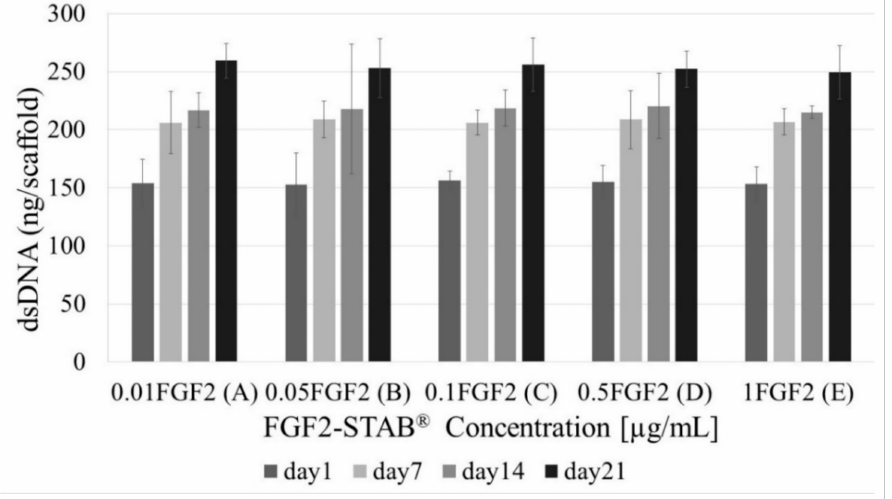
Figure 9. dsDNA assay with increasing FGF2-STAB ® concentration (0.01, 0.05, 0.1, 0.5 and 1 µ g/mL, for A – E , respectively) after 1, 7, 14 and 21 days of incubation. No statistical significance was observed. However, there was a statistical significance in the Coll I expression by 3T3-A31 fibroblasts as shown in Figure 10. While the concentration 0.1 µ g/mL of FGF2-STAB ® in Coll/Chit samples exhibited the best Coll expression within the first 24 h, in long-term study (21 days) the best sample seem to be scaffold involving 0.5 µ g/mL of FGF2-STAB ® .